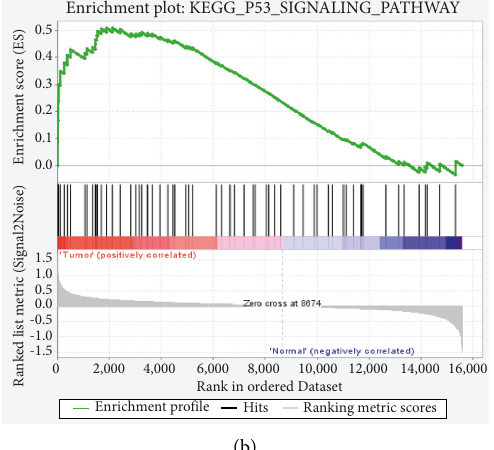
(Figure 3) using String web V.11.5 (https://string-db.org/) [41].